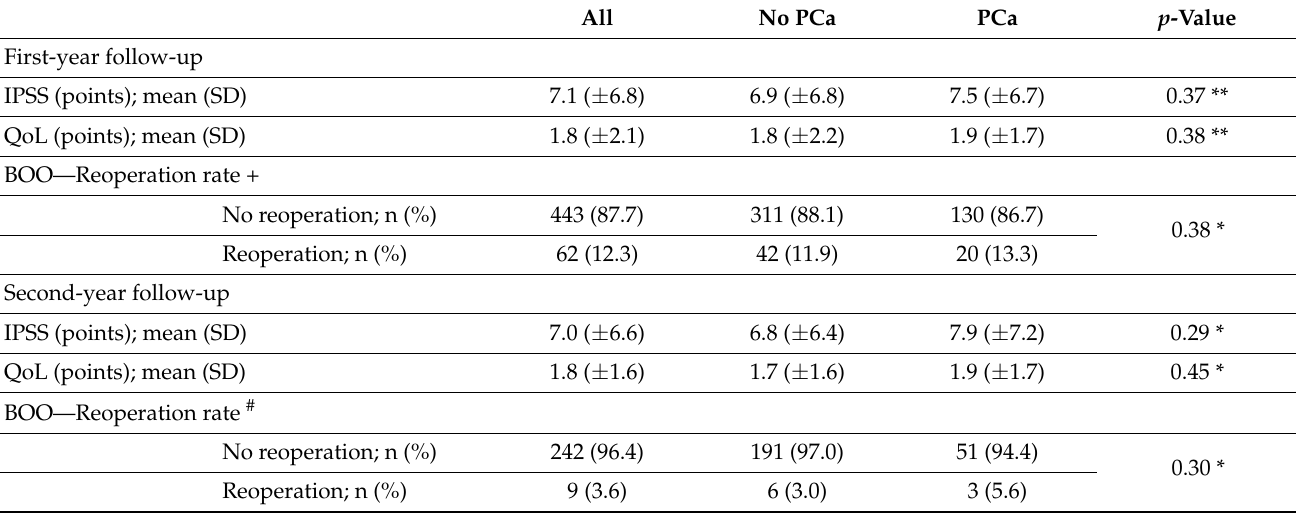
Table 3. First- and second-year follow-up data of patients stratified by final pathology. All No PCa PCa p